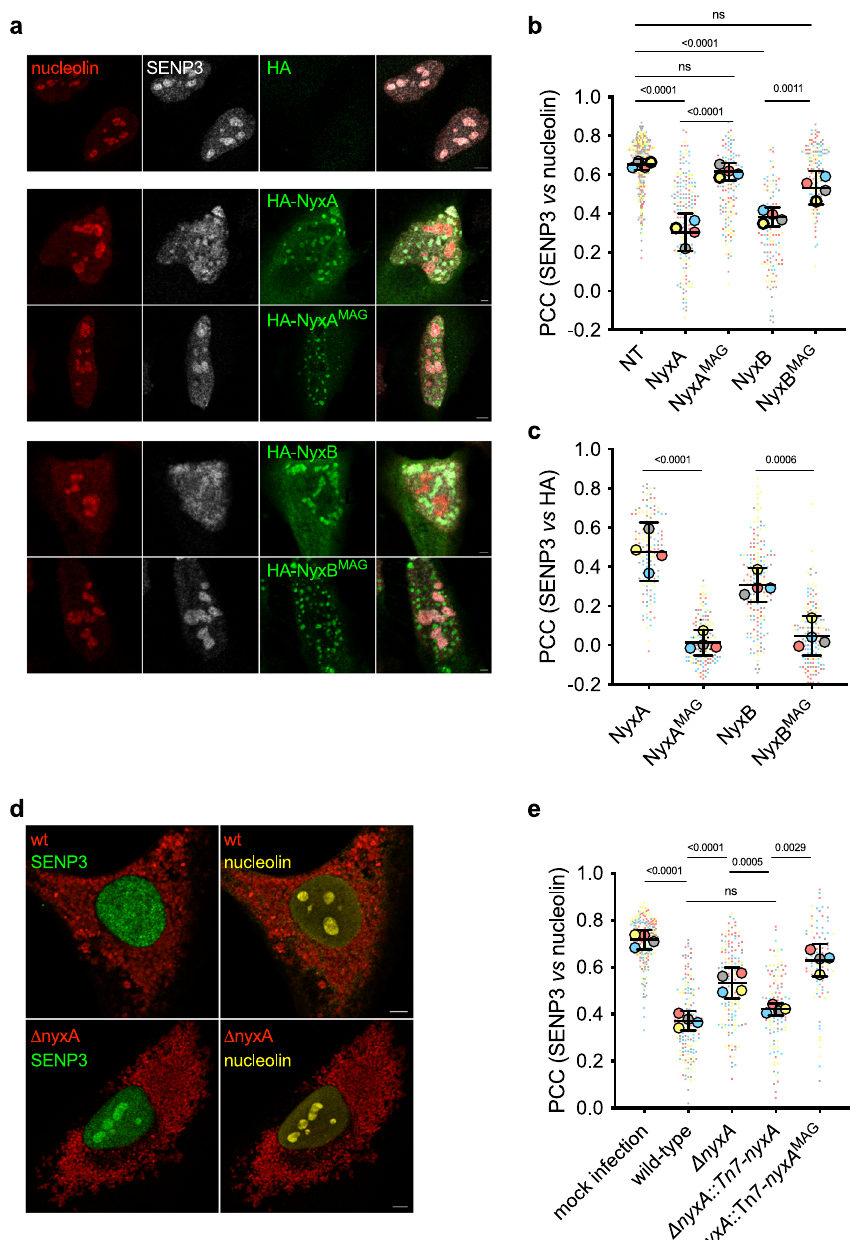
Fig. 4 | The Brucella Nyx effectors directly perturb the SENP3 nucleolar loca- lisation in host cells, including during infection. a Representative confocal microscopy images of HeLa cells expressing the HA empty vector, HA-NyxA, HA- NyxA MAG , HA-NyxB and HA-NyxB MAG . Nucleolin (red), SENP3 (white) and HA (green) were revealed with speci fi c antibodies. b Quanti fi cation of the